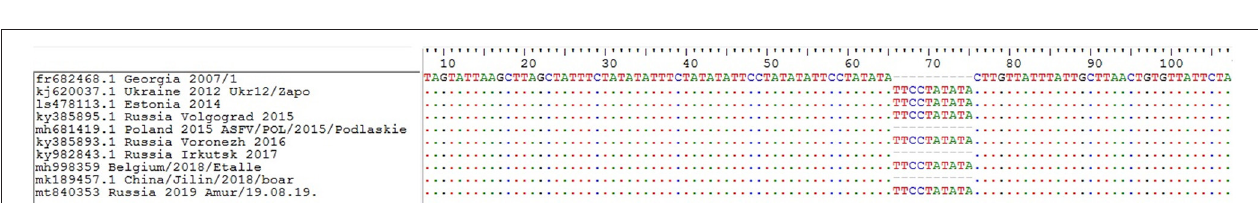
FIGURE 7 | Nucleotide sequence alignment of the partial I73R and I329L intergenic region of the representative African wine fever virus strains. GenBank accession numbers, country, and year of collection are indicated.